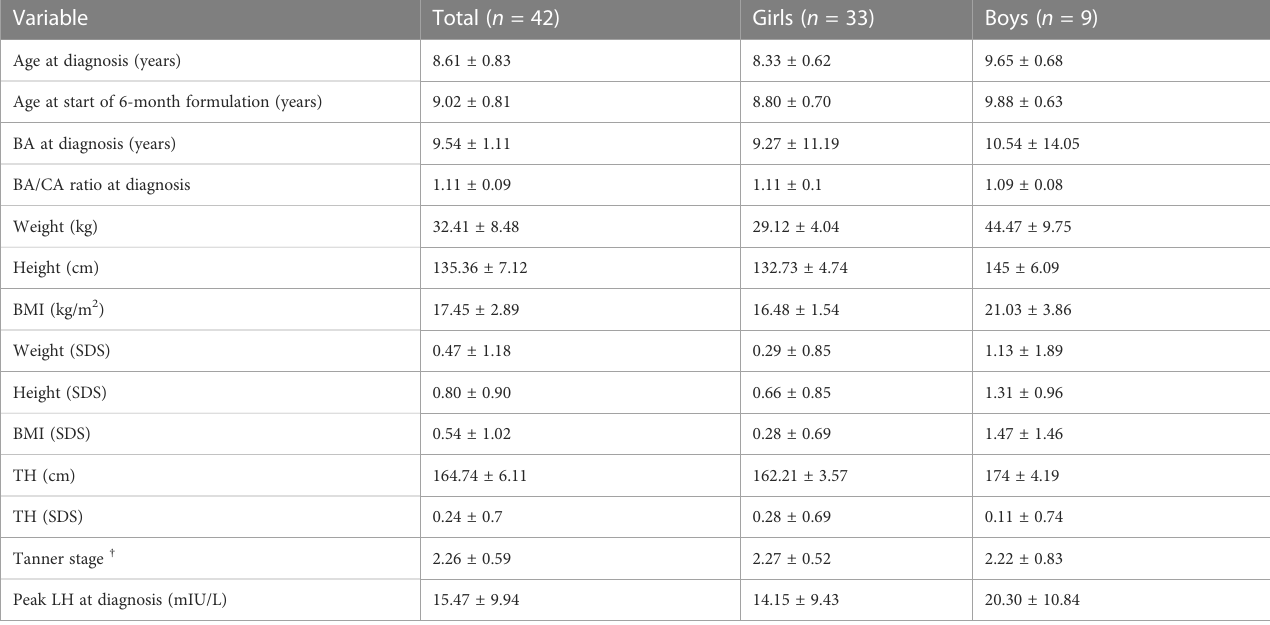
TABLE 1 Clinical, demographic, and laboratory characteristics of the patients at baseline.